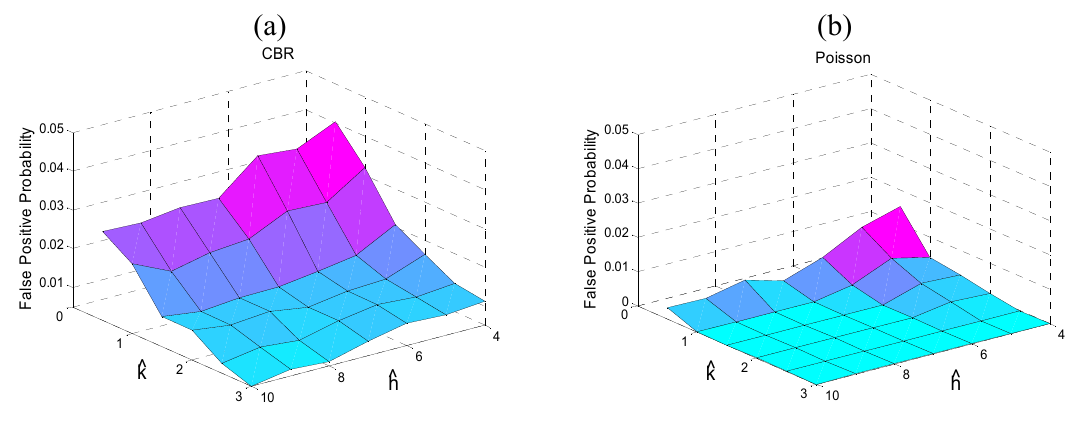
Figure 10. (a) False positive probability for different values of ˆ h and ˆ k for CBR traffic; (b) False positive probability for different values of ˆ h and ˆ k for Poisson traffic.